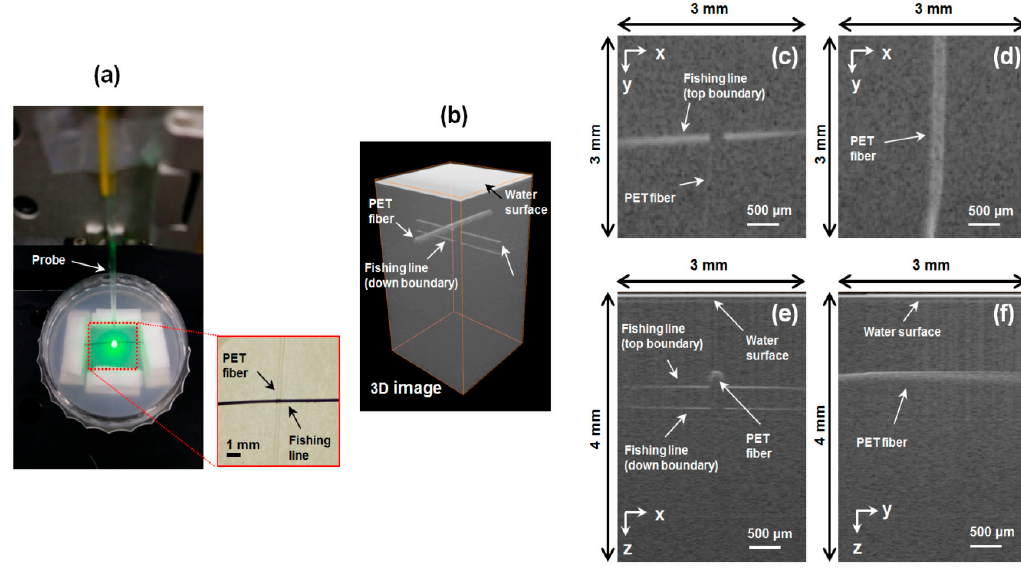
Figure 4. OCT measurements of the phantom. ( a ) Photograph of the sample arm and the phantom. The excitation area of the pulsed laser (wavelength of 532 nm) is seen with green color and the inset is a photograph of the phantom; ( b ) The obtained 3D OCT image of the phantom; ( c ) Cross-sectional image in the xy plane taken at the top boundary of the fishing line; ( d ) The same as ( c ) but taken at the black polyethylene terephthalate (PET) fiber; ( e ) Cross-sectional image in the xz plane taken at the cross point of the fishing line and PET fiber; ( f ) The same as ( e ) but taken along the orthogonal direction.